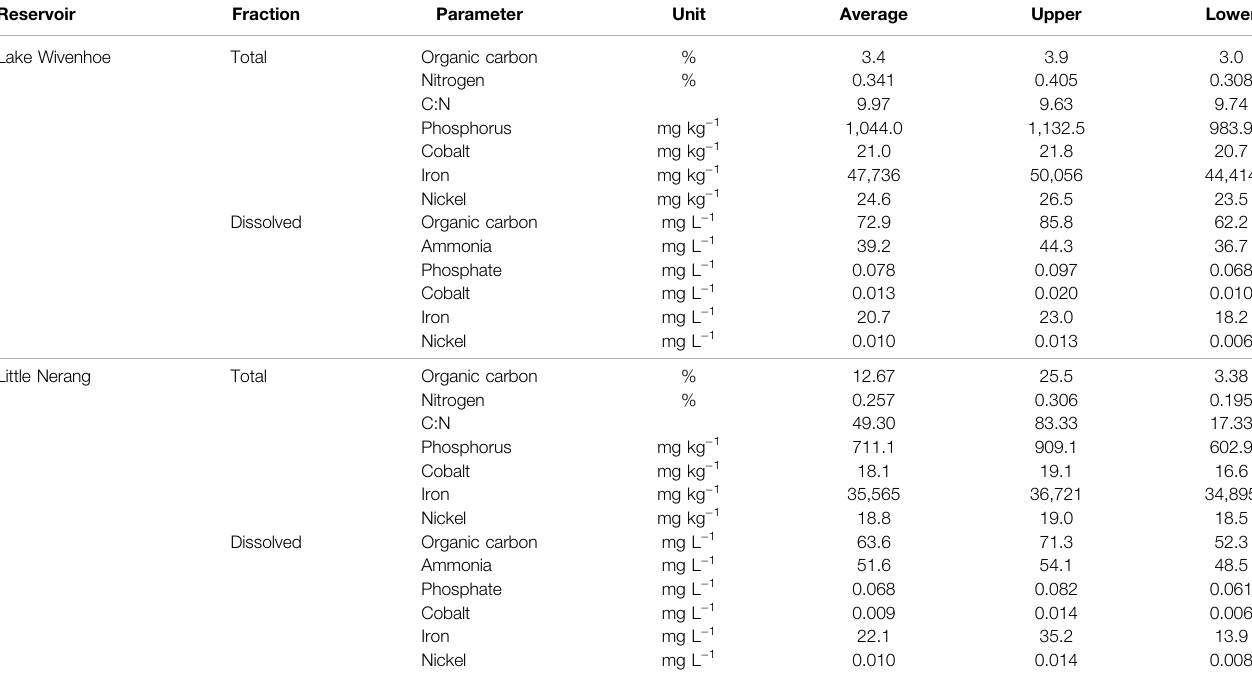
TABLE 2 | Total and dissolved fractions of selected key sediment macronutrient and trace metals from Lake Wivenhoe and Little Nerang Dam. Reservoir